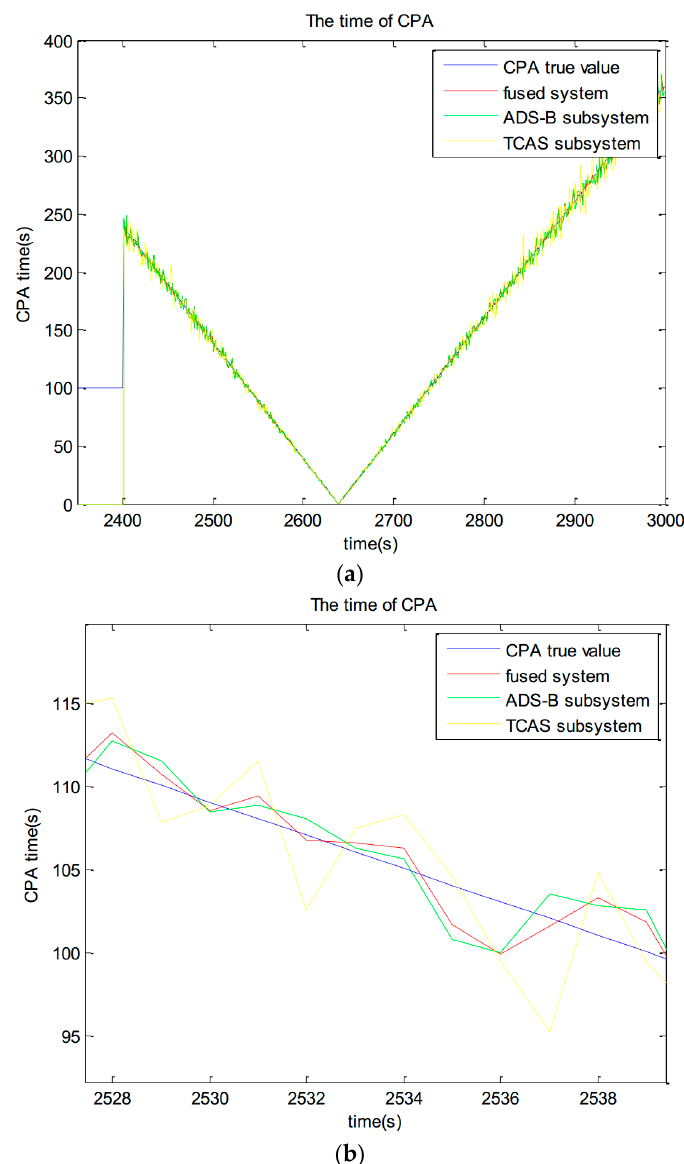
Figure 11. The CPA calculation results. ( a ) The CPA calculation results in large time period; ( b ) The CPA calculation results in small time period.